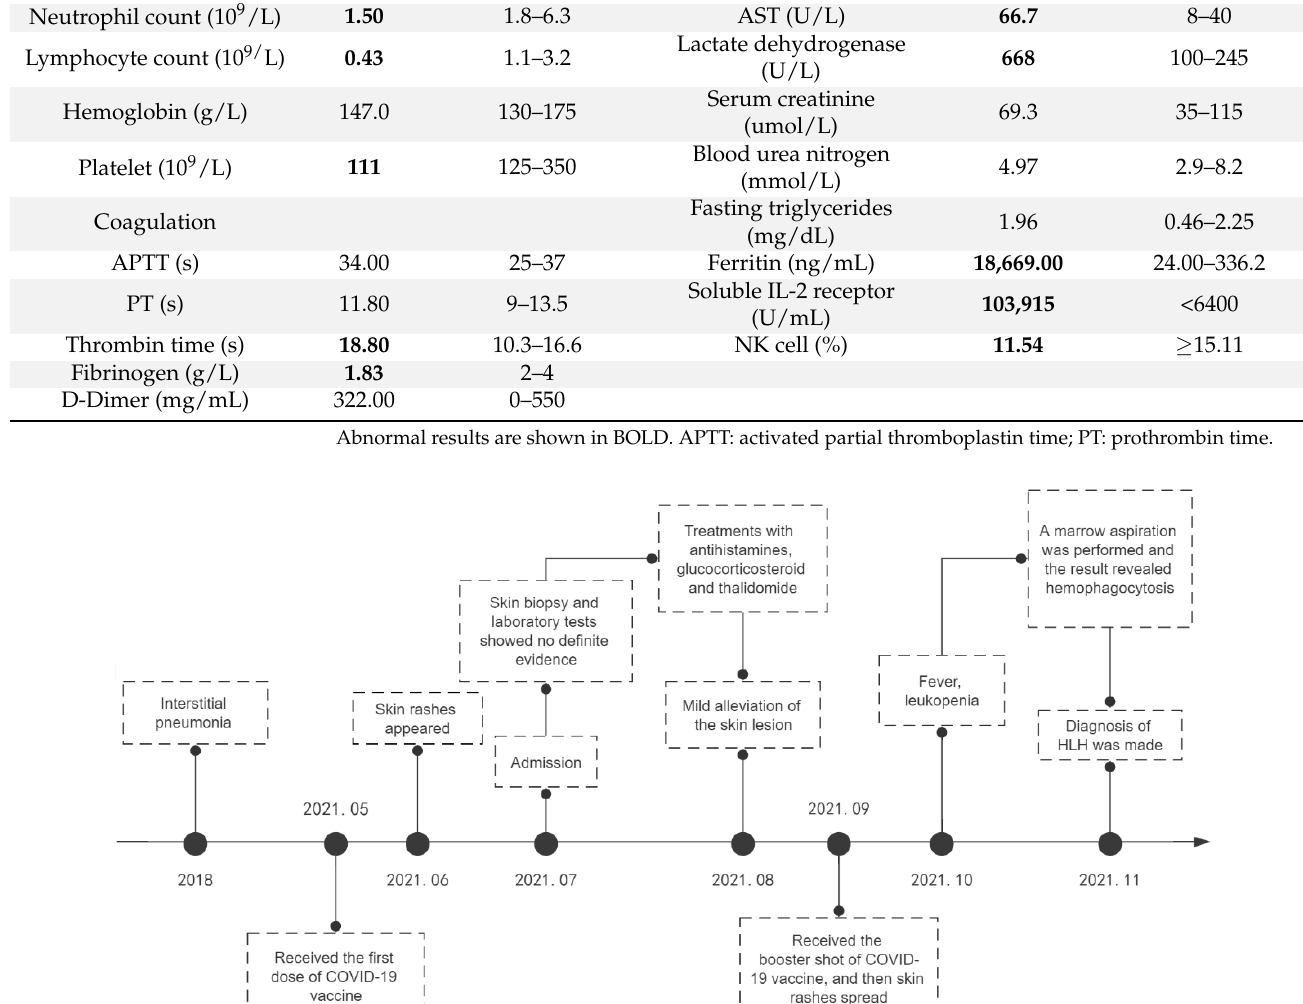
Figure 3. A coherent timeline indicating the date of this case.